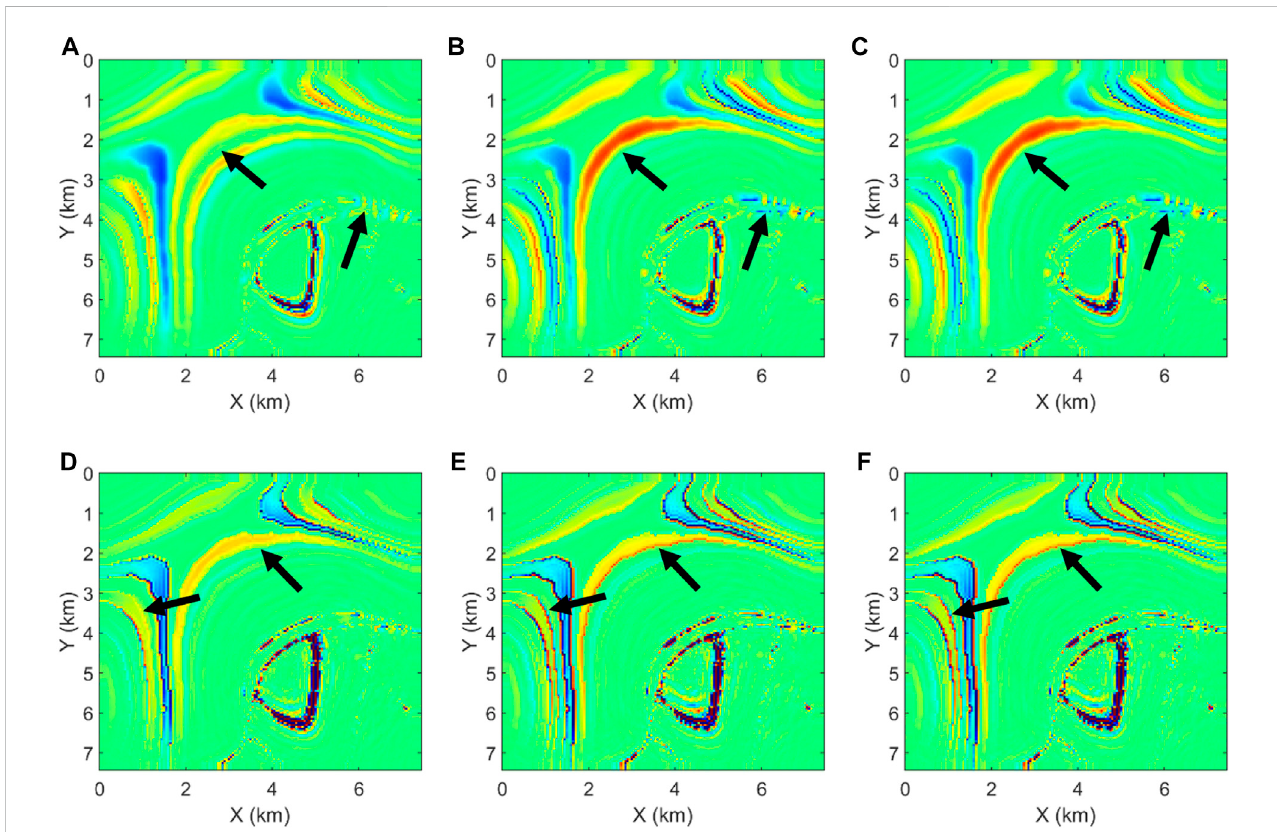
FIGURE 20 Imageslicesat z =4.5 kmusingthe (A) and (D) STSand (B) and (E) FTSmethodsand (C) and (F) references. (A) , (B) ,and (C) arePPimages,and (D) , (E) ,and (F) are PS